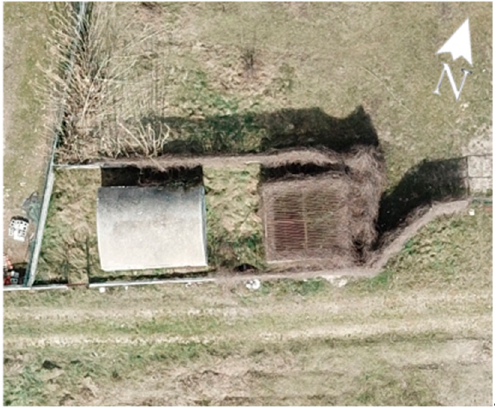
Figure 9. The external parts of the well n°32 built in the 19th century.